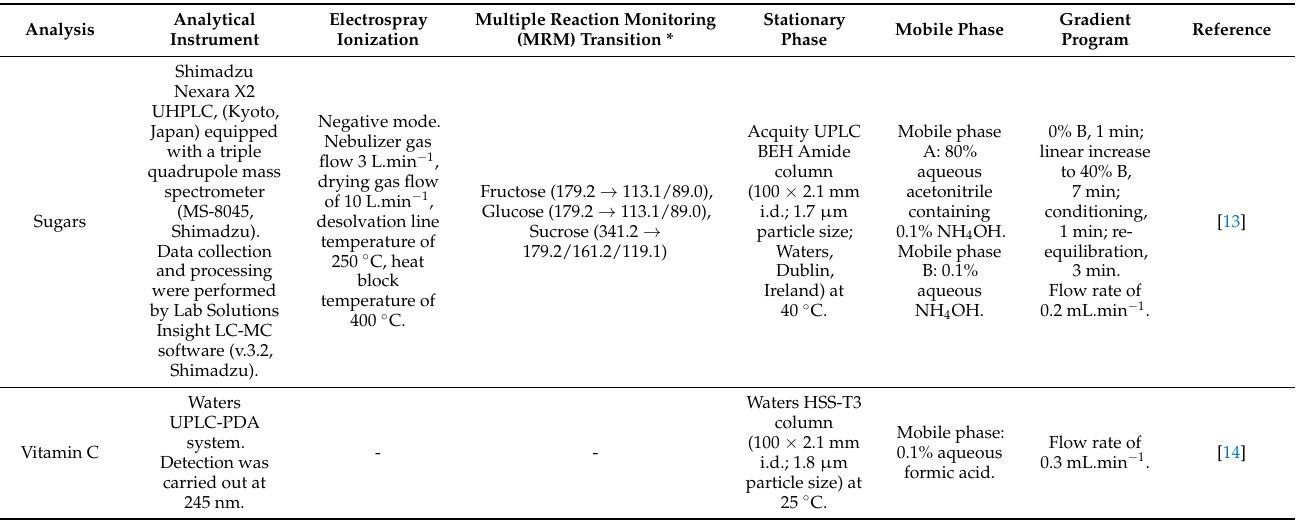
Table 1. Details of chromatographical and mass spectrometry analysis of soluble sugars, vitamin C, organic acids, and non-anthocyanin